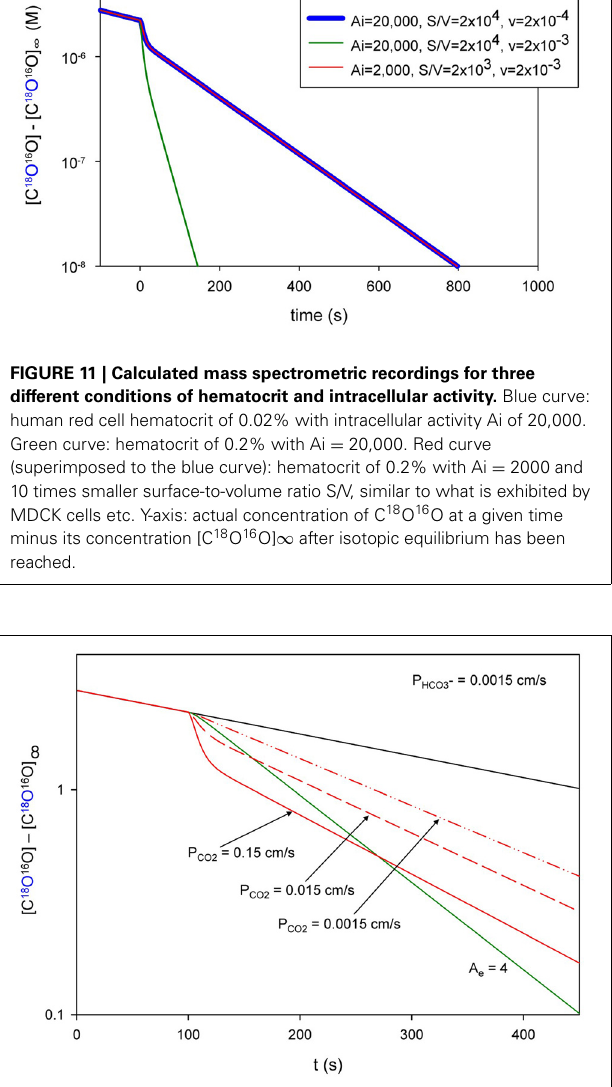
FIGURE 12 | Calculated time courses of mass spectrometric recordings from human red cells at a hematocrit of 0.02%. The red curves are of 0.15cm/s (—), 0.015cm/s (———) and 0.0015cm/s calculated for a P CO 2 ( · — ··· — · ). The green line (—) indicates an extracellular CA activity Ae of 4, if free CA is added to the solution in the absence of cells. If the red cells studied in the three red curves were lysed, they would also cause an Ae of 4. Denotation of axes identical to Figure 11